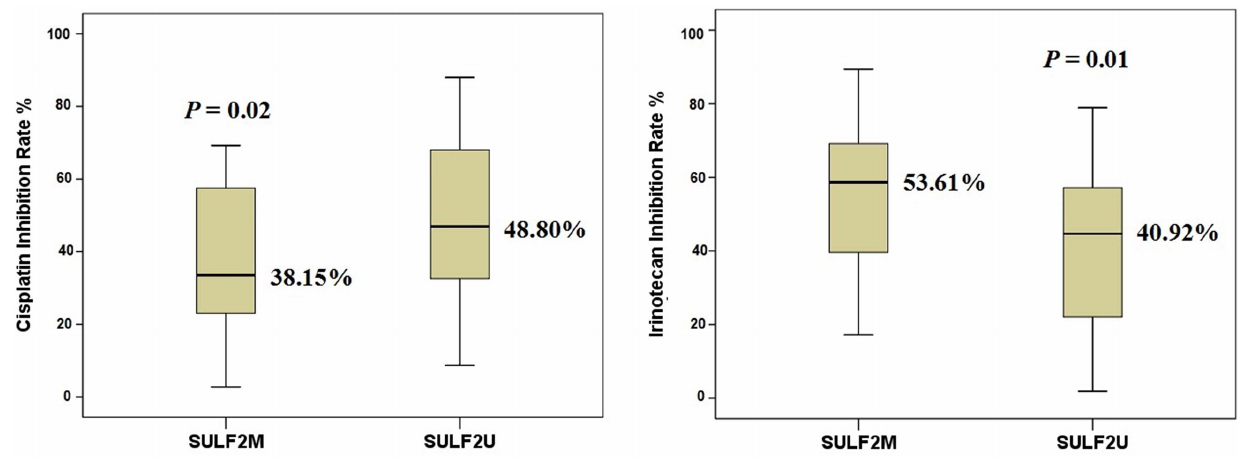
Figure 1. Samples with SULF2U were more sensitive to cisplatin and those with SULF2M (48.80% vs. 38.15%, P =0.02, n=100, t-test); samples with SULF2M were more sensitive to irinotecan than SULF2U (53.61% vs. 40.92%, P =0.01, n=100, t-test). The median is the central line in each box.